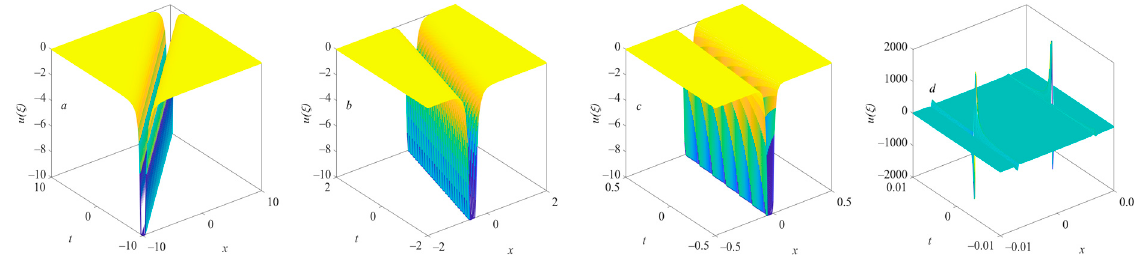
Figure 6. Evolution of solitary waves with n in u 6 n when k = 1: ( a ) n = 1, ( b ) n = 2, ( c ) n = 3, and ( d ) n = 4.